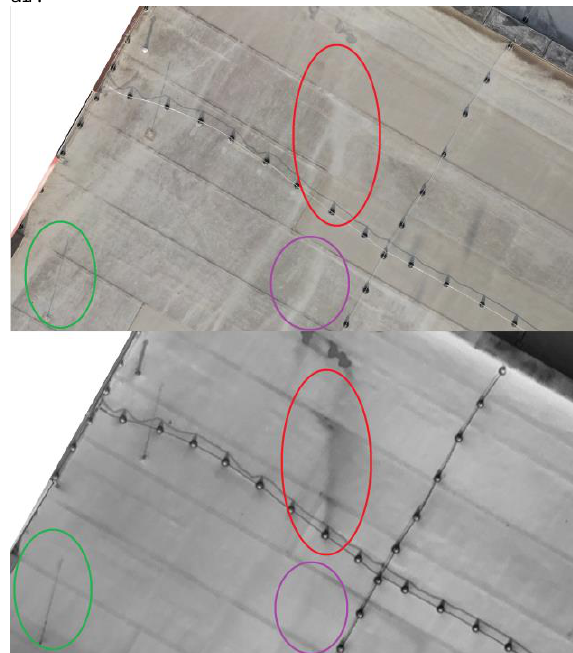
Figure 5 . Roof detail, RGB (up), and TIR (down) ortofoto, green ellipse (shadow), red ellipse (leakage) and purple (colorized roof)